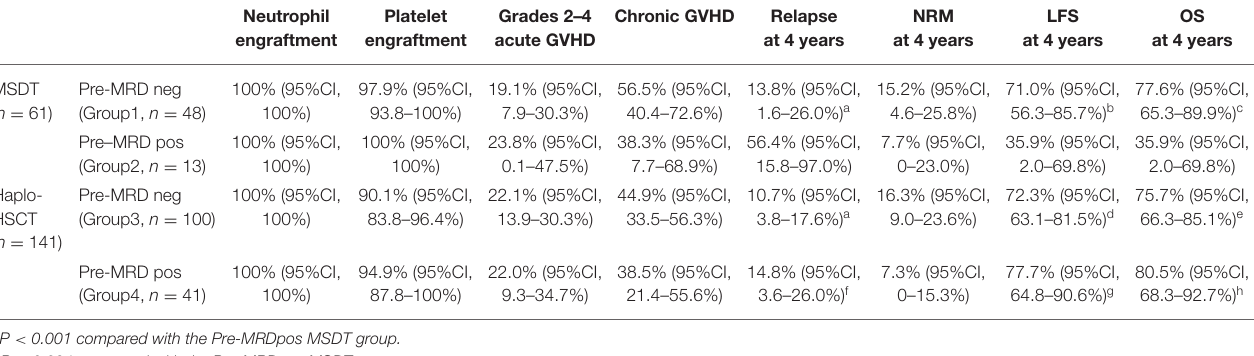
TABLE 3 | Transplant outcomes for patients that underwent allogeneic stem cell transplantation ( n = 202). Neutrophil Platelet engraftment